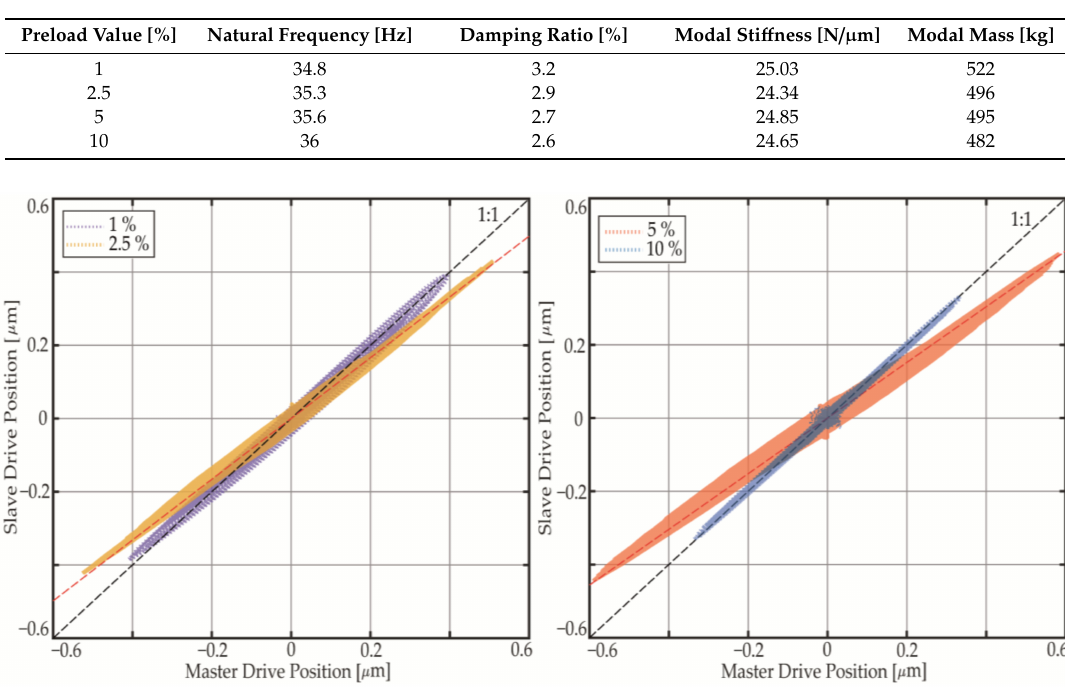
Table 1. Modal parameters of the machine tool for di ff erent preload values.